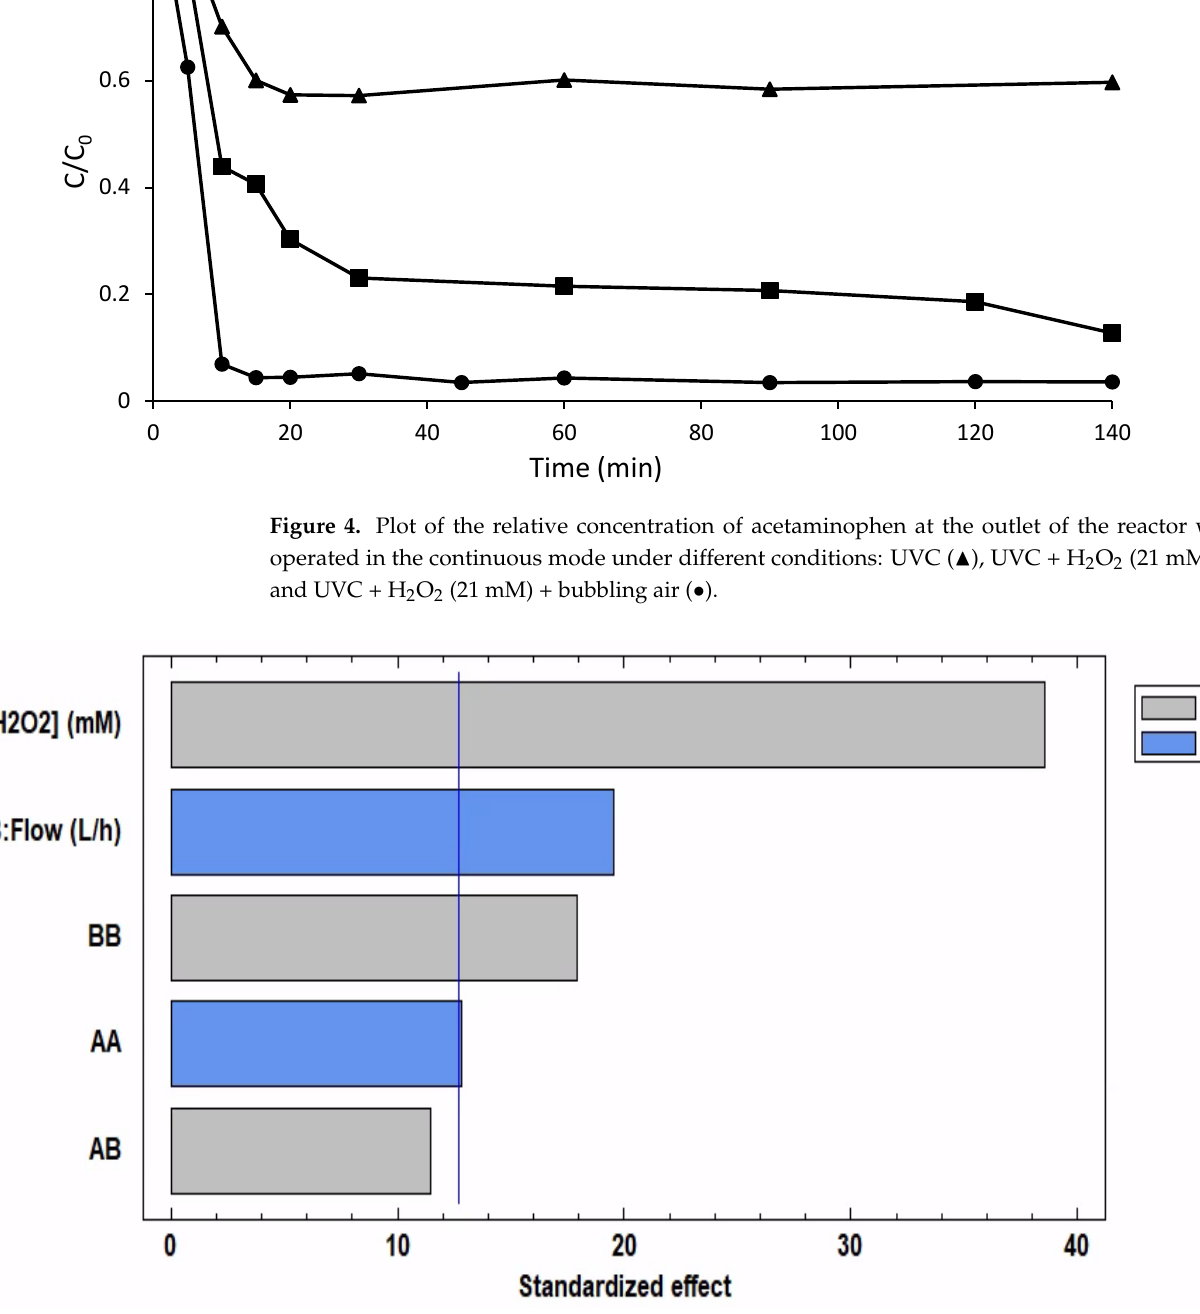
Figure 5. Pareto Chart showing the significance of the studied parameters, their interactions, and the quadratic values. The blue line accounts for the limit of significance